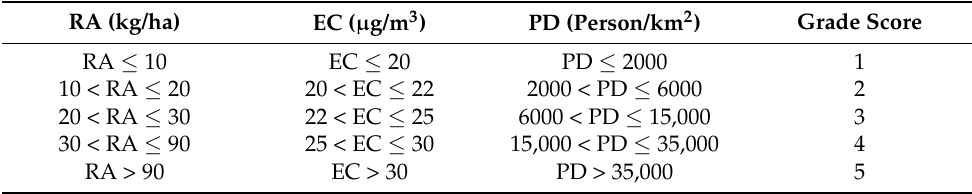
Table 1. Grades of human population density (PD), PM 2.5 concentration (EC), and removal capacity (RA) in Shanghai. RA (kg/ha) EC ( µ g/m 3 ) PD (Person/km 2 ) Grade